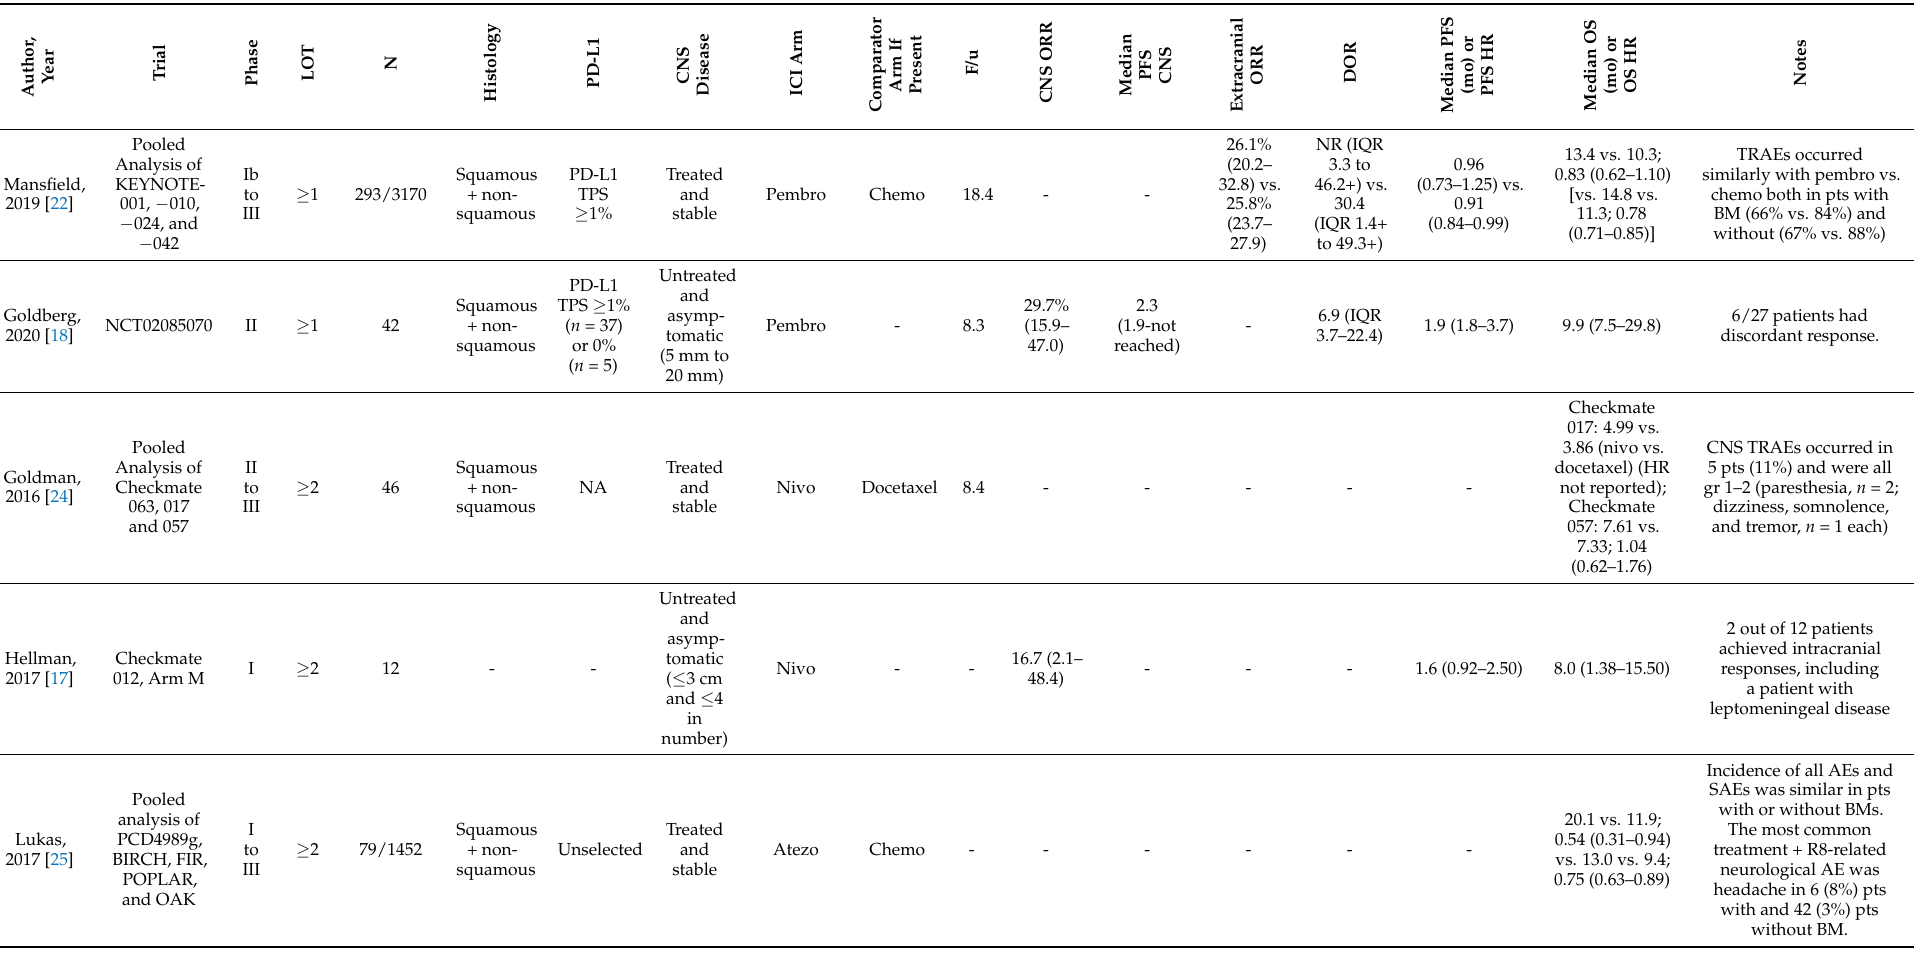
Table 1. Summary of clinical studies with immune checkpoint inhibitors in patients with brain